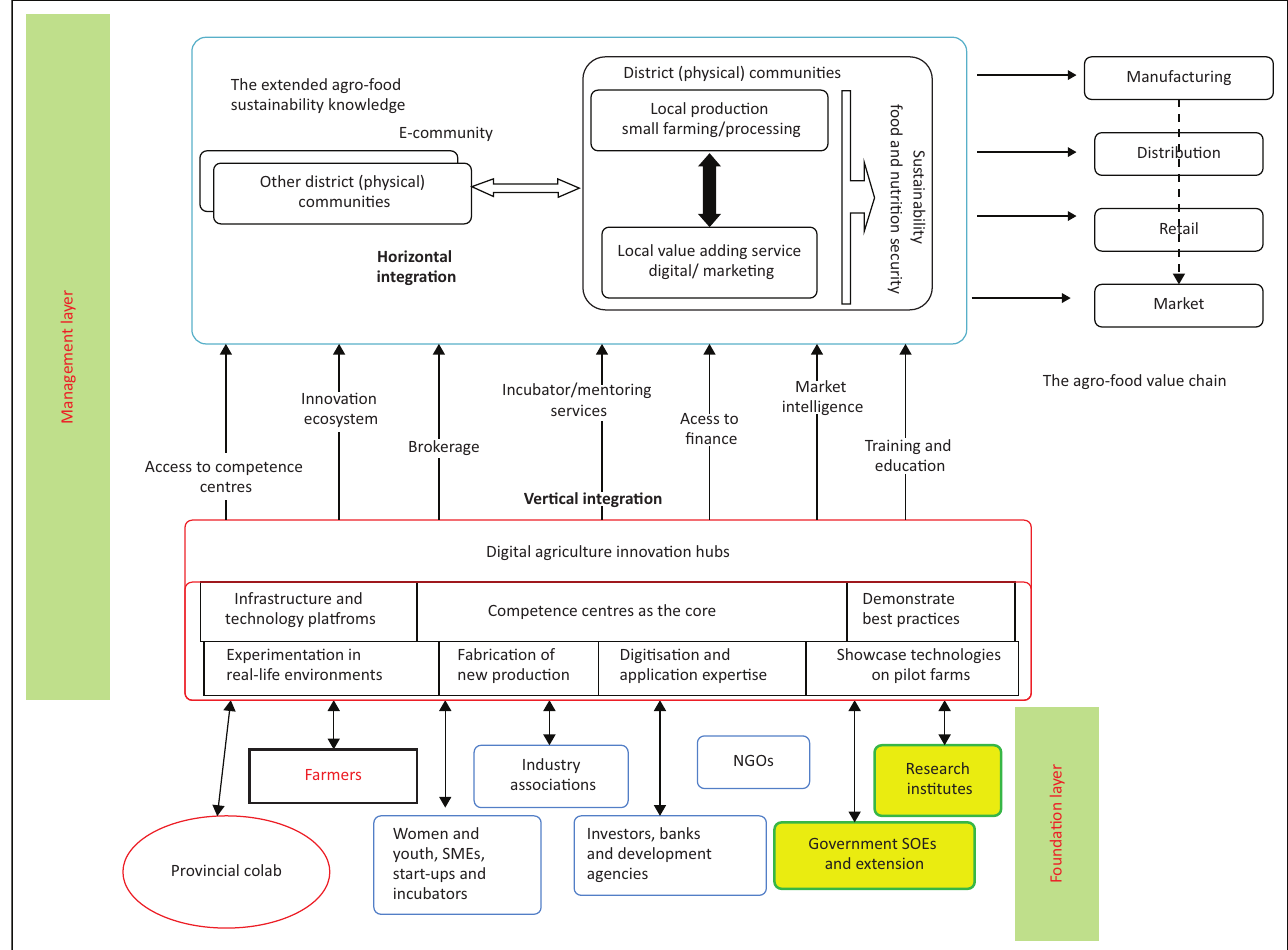
FIGURE 9: Institutional arrangement for a digital agriculture value